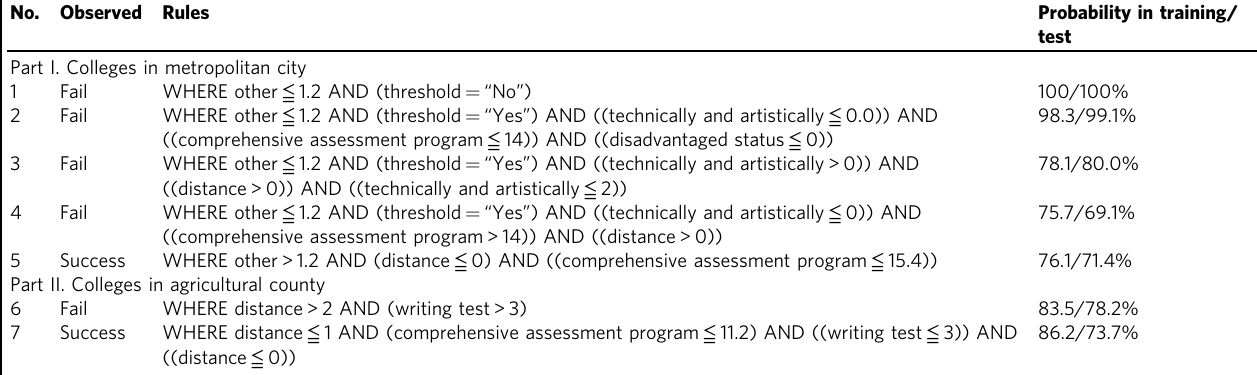
Table 6 Organization of important rules from the decision